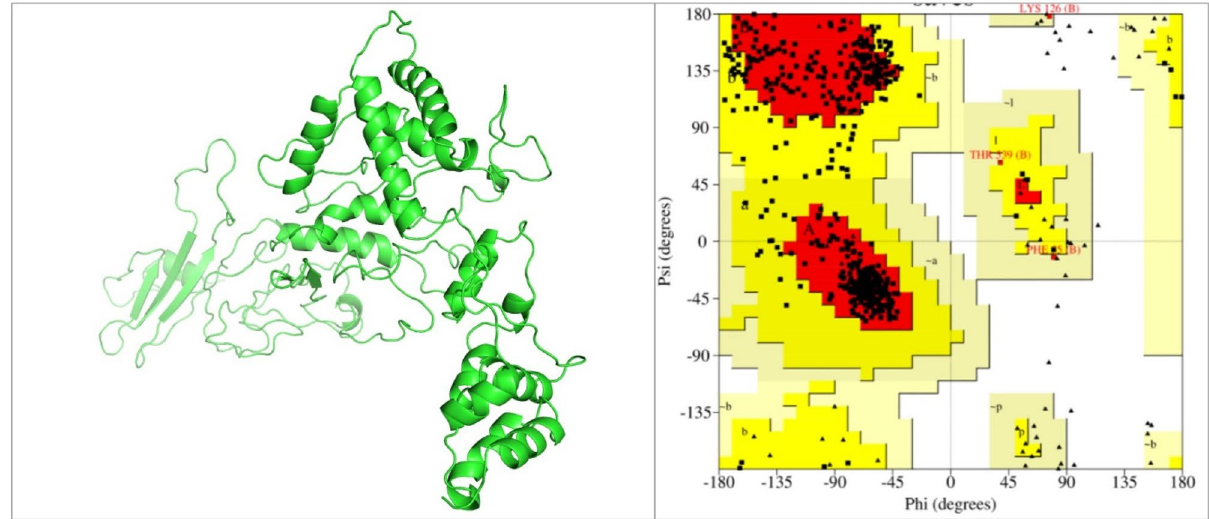
Figure 4. 3D structure of final subunit multi-epitopes vaccine construct (left: created using Pymol version 2.3), and Ramachandran plot (right: obtained from SAVES v6.0 https:// saves. mbi. ucla. edu/) analysis shows that 82.2% of the residues are in the most favoured regions 17.1% within the allowed regions and no residue in the disallowed